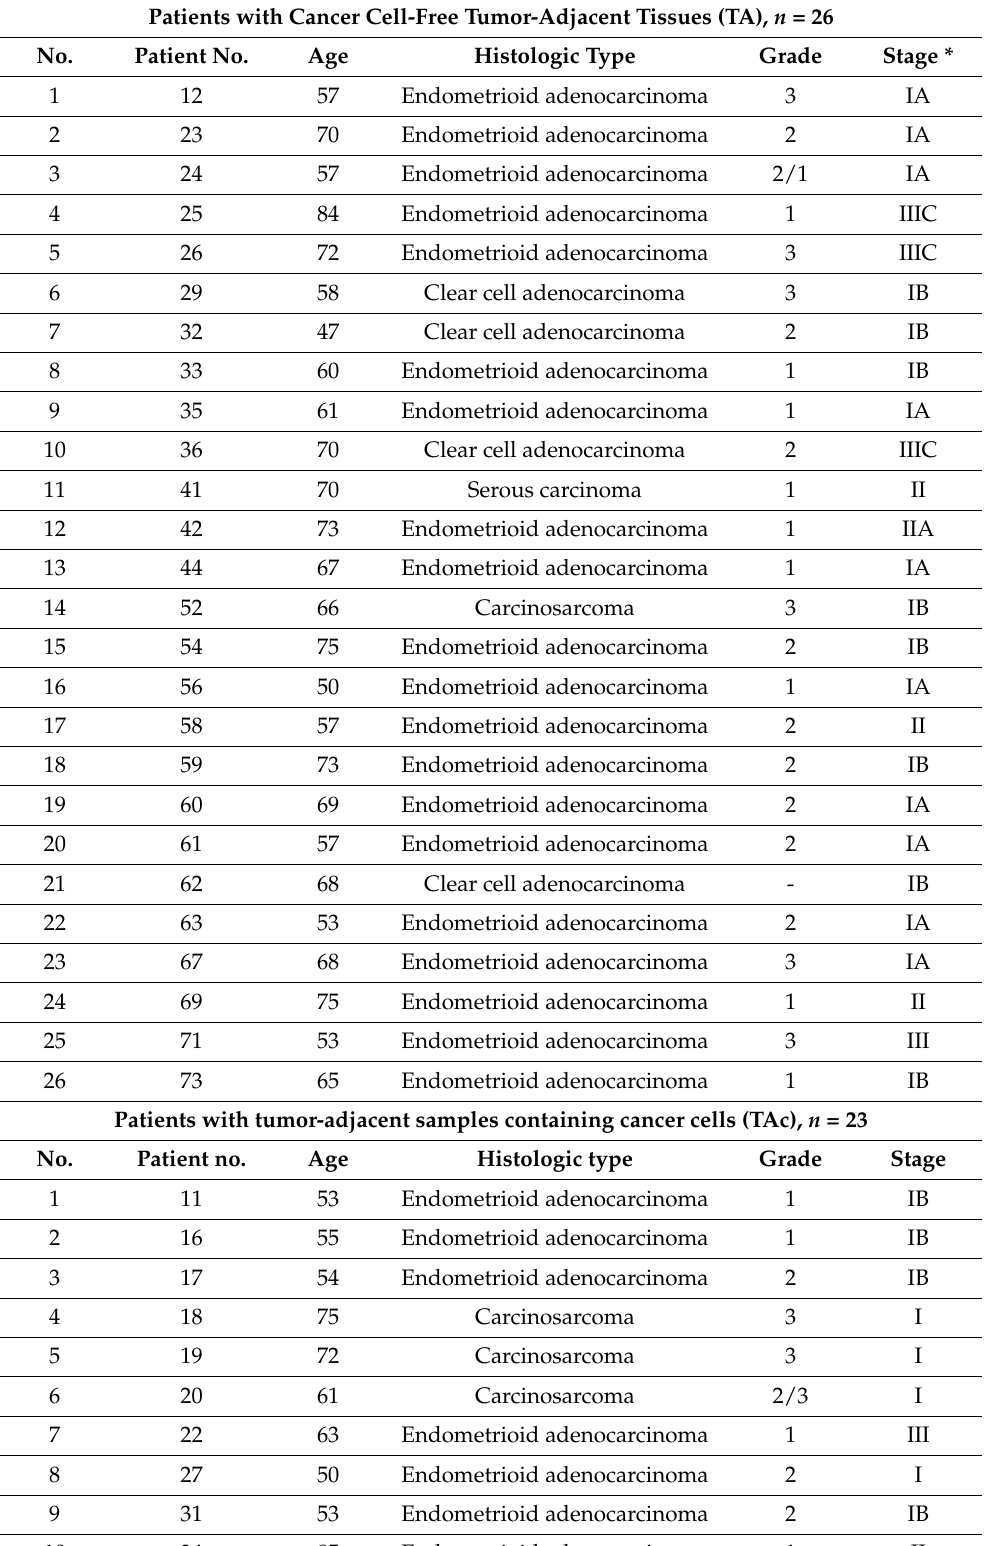
Table 1. Characteristics of endometrial cancer patients. Patients with Cancer Cell-Free Tumor-Adjacent Tissues (TA), n =